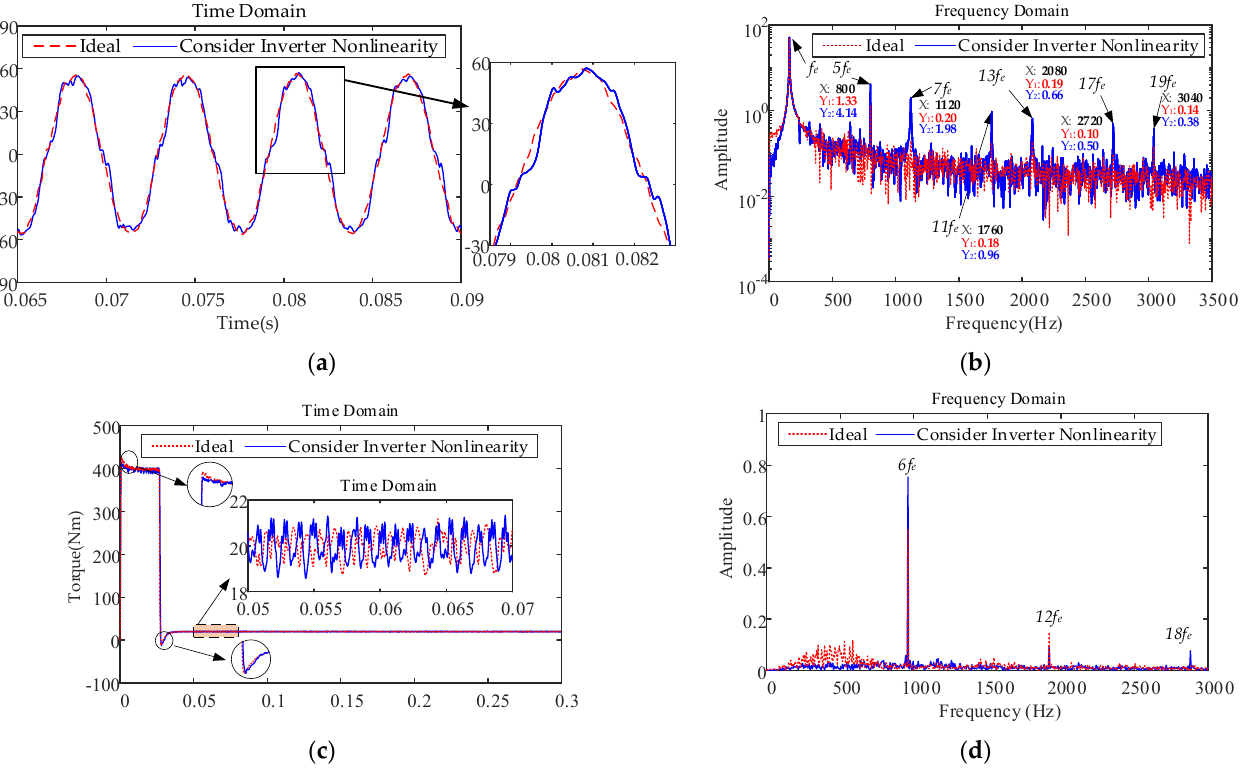
Figure 11. Comparison results of current and electromagnetic torque: ( a ) time domain of A ‐ phase current; ( b ) frequency domain of A ‐ phase current; ( c ) time domain of electromagnetic torque; ( d ) frequency domain of electromagnetic torque.